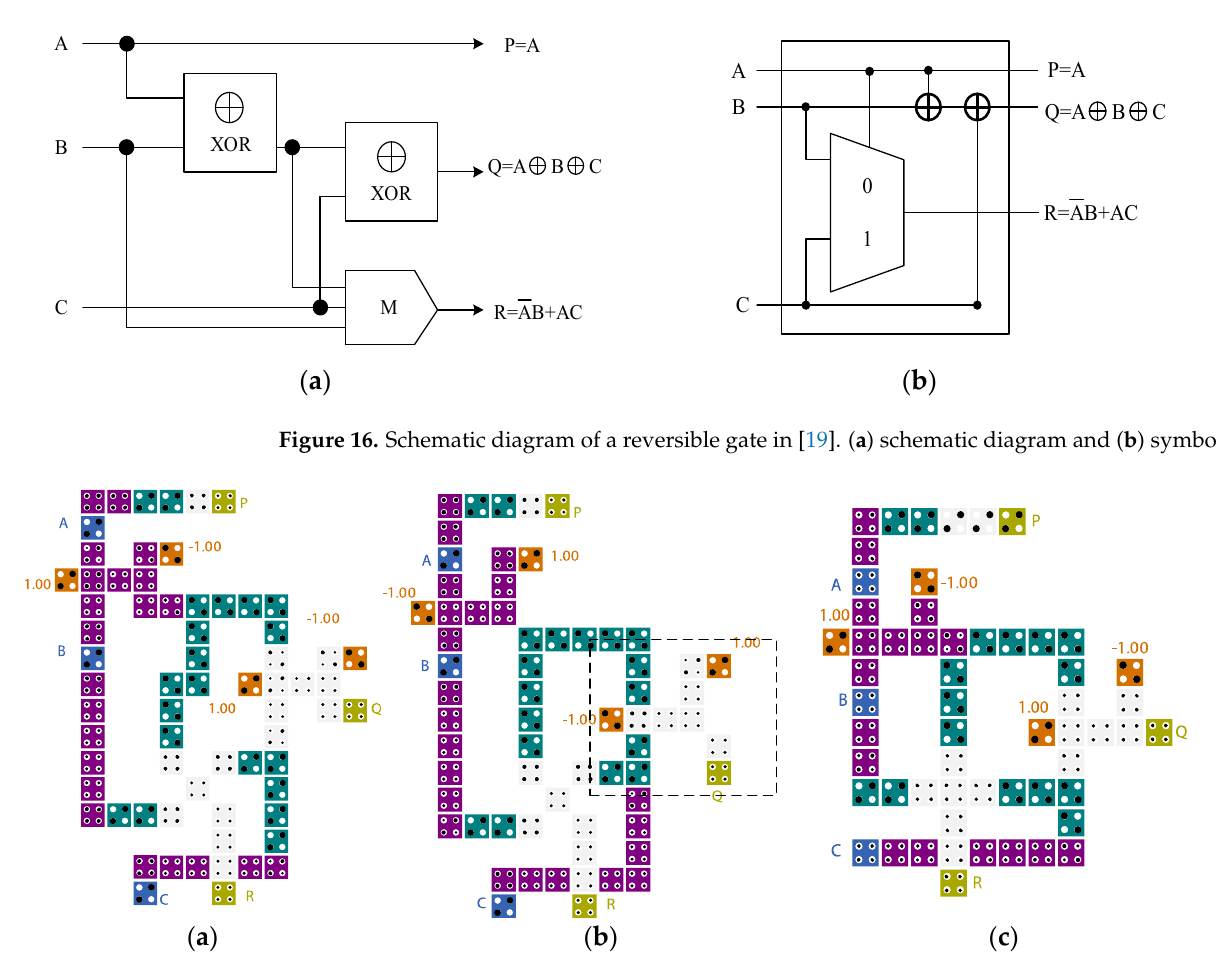
15 of 23 ( c ) Figure 15. Simulation results of the proposed 2-to-1 multiplexers: ( a ) 2-to-1 MUX1, ( b ) 2-to-1 MUX2, and ( c ) 2-to-1 MUX3. In 2017, Chabi et al. [19] proposed a new reversible gate, and the schematic diagram is shown in Figure 16. The reversible gate requires three inputs and obtains three outputs.